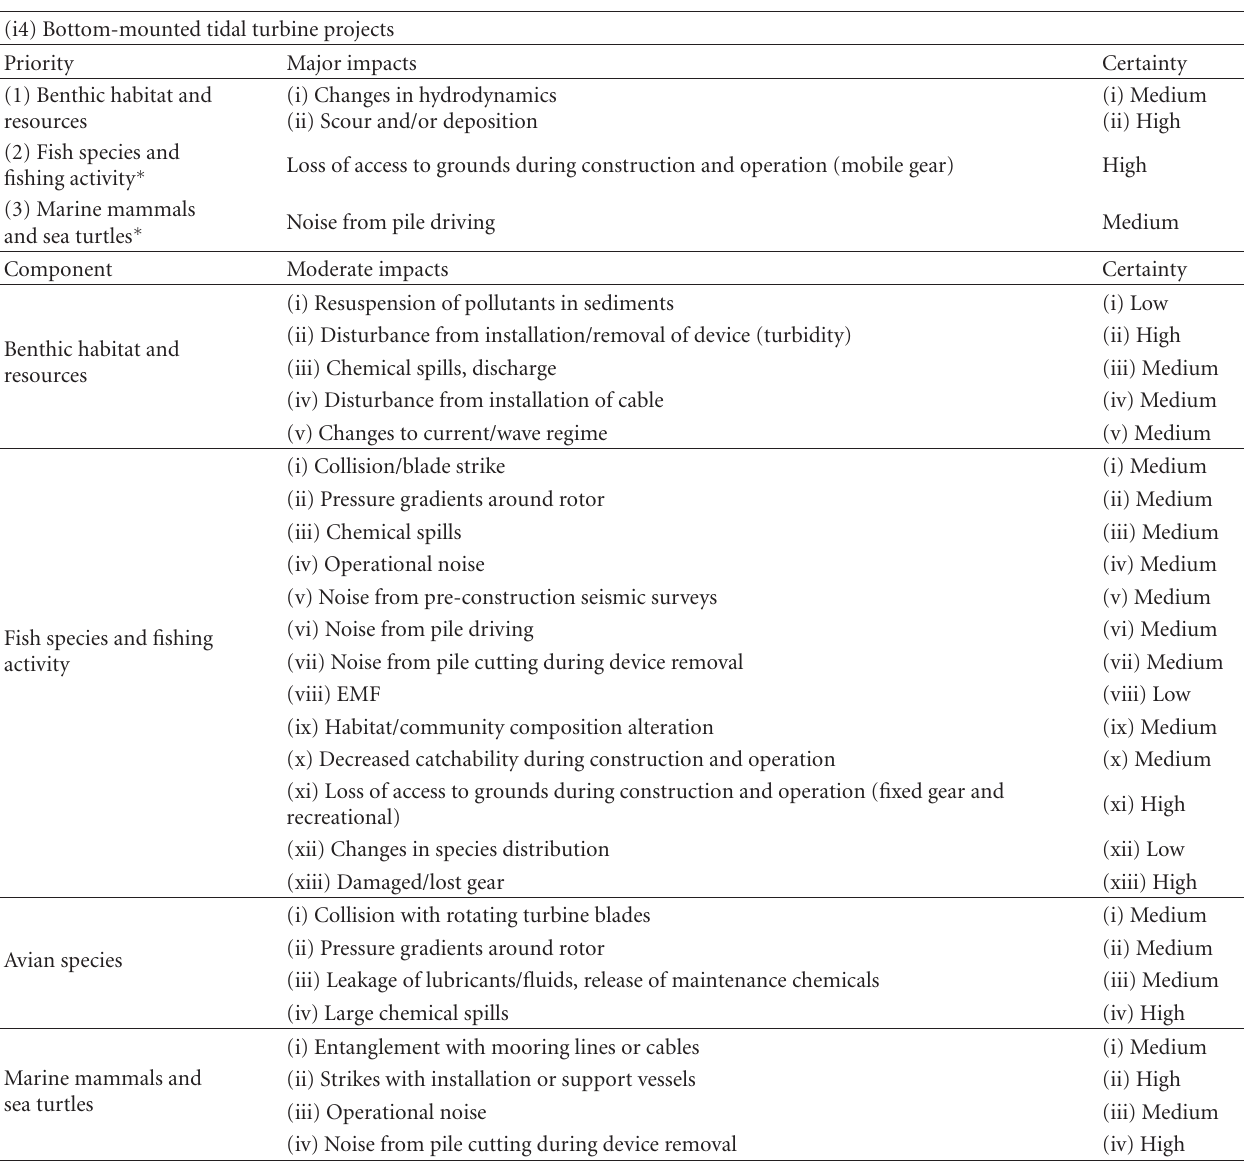
Table 6: A description of the potential impacts resulting from bottom-mounted tidal turbine projects. See text, Section 3.3, for a narrative summary of this development scenario. Ecosystem components are ranked by their proportion of the major impacts. Moderate impacts are listed in the order they appear in the renewable energy impact